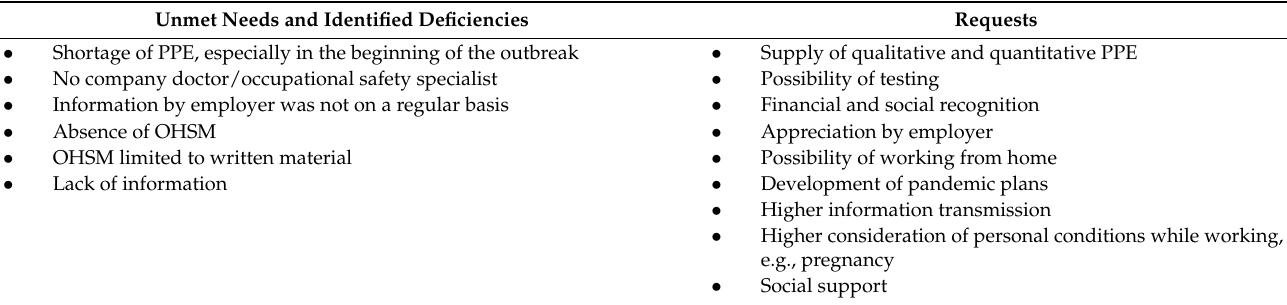
Table 4. Unmet needs, identifiable deficiencies and further requests in terms of OHSM of outpatient care services. Unmet Needs and Identified